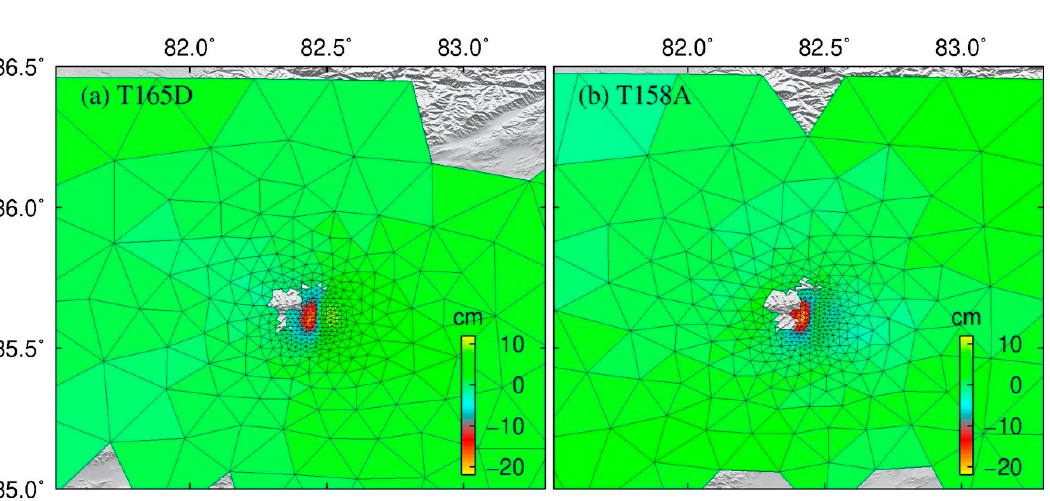
Figure 6. Subsampling points of InSAR data for Sentinel-1 track ( a ) T165D and ( b ) T158A with the resolution-based sampling method [44].